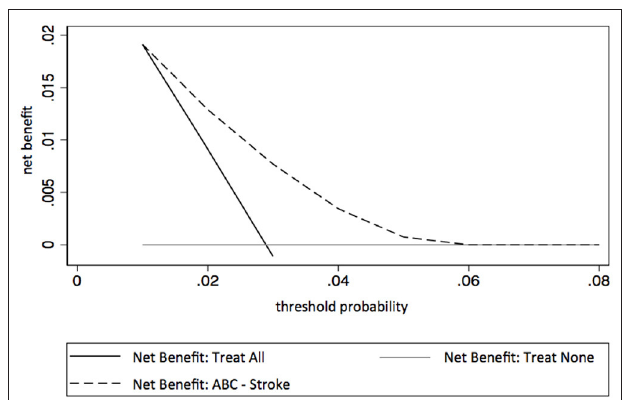
FIGURE 2 | Decision curve analysis for the ABC-stroke score. Net benefit (y-axis) reflects whether basing ischemic stroke risk prediction on the ABC - stroke score provides greater benefit than harm. The unit of net benefit is true positives (ischemic strokes) per patients. A net benefit of 0.01 means that using the ABC - stroke score increases the number of correctly predicted ischemic strokes by 1 out of 100 target patients, without changing the number of false-positive stroke predictions. Threshold probability (x-axis) refers to the cut-offs of predicted ischemic stroke risk used to decide treatment ( 19, 20).